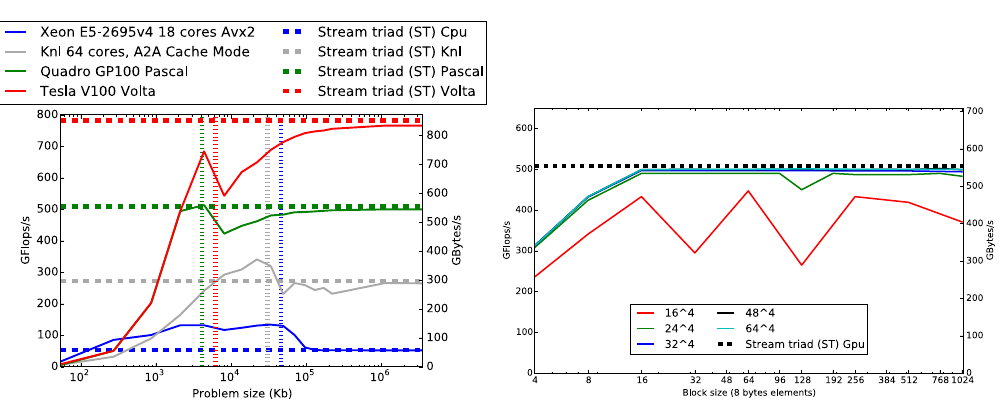
SU(3) streaming bandwidth Figure 2. Comparison of OpenACC SU(3) SU(3) Figure 1. Complex SU(3) × × streaming bandwidth with and without coalesced Figure 3. Performance of the miniapp in several archi- pointer. tectures. The vertical lines indicate the cache size, the horizontal ones show the memory bandwidth obtained in a stream triad test. In all cases we can easily saturate the memory bandwidth of the machine.